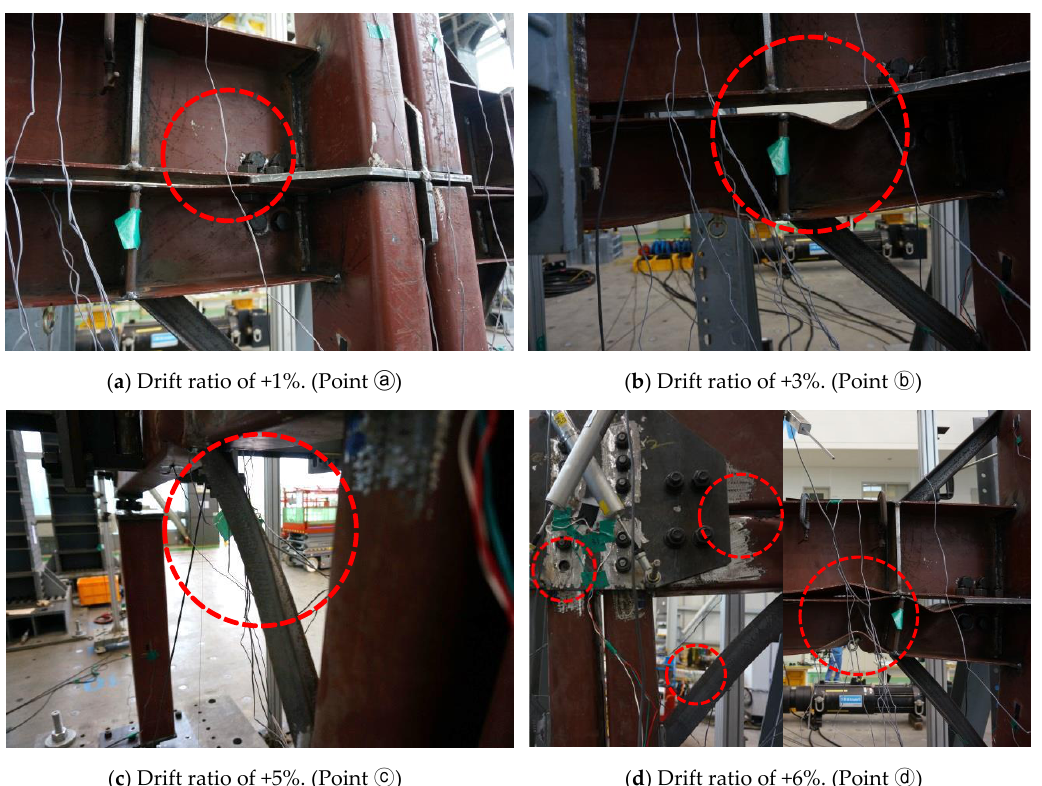
Figure 14. Failure sequence of Specimen IC_OB_B.